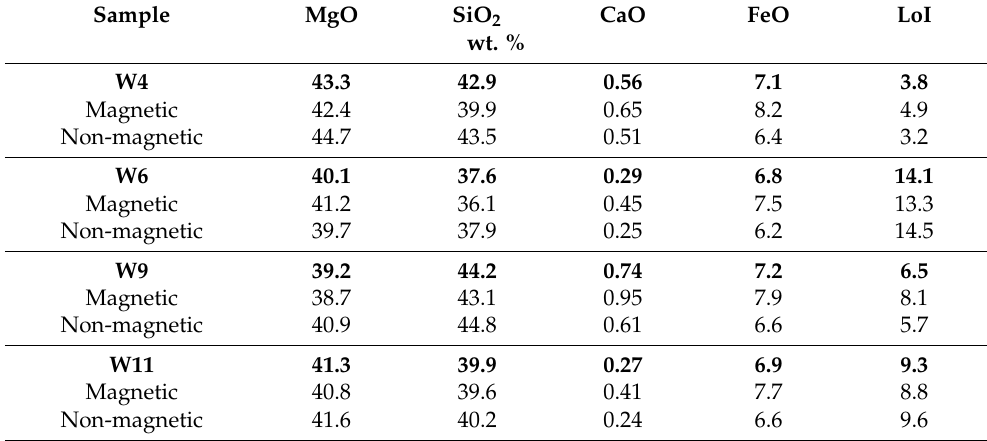
Magnetic Table 3. Chemical analysis using XRF and LoI of magnetic and non-magnetic fractions. Sample